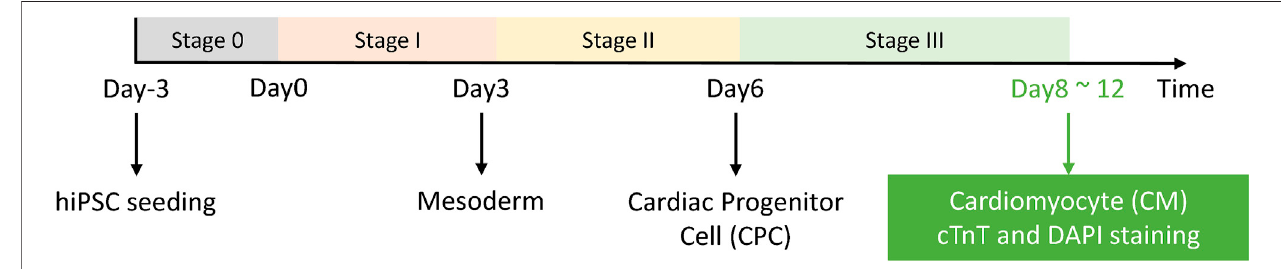
FIGURE 3 | HiPSC-CM experimental system. Stage 0 is the hiPSC seeding and growth stage, and the differentiation process starts from day 0. After stage III, the cells were fi xed and stained for readout and further